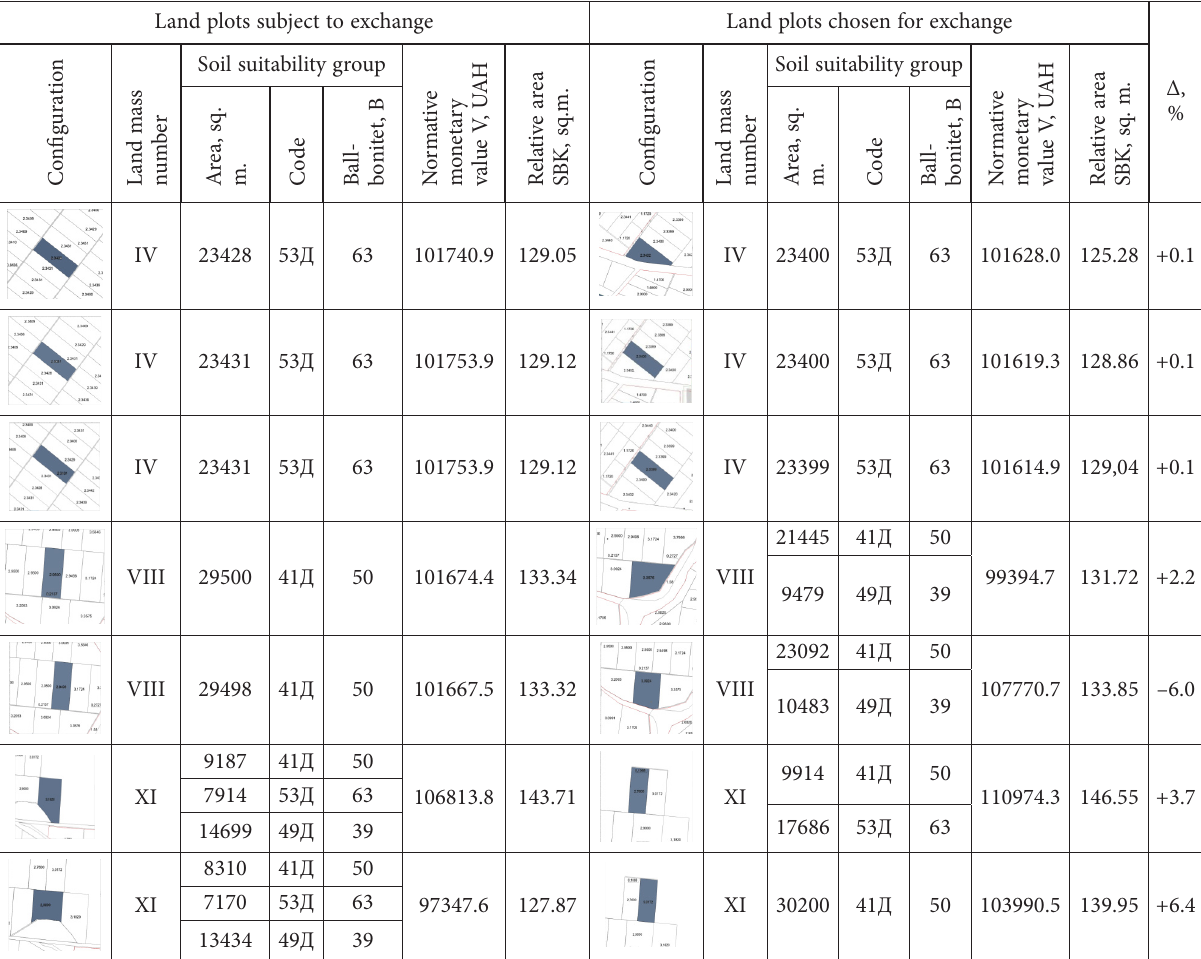
Table 1. Land plots exchange in the land consolidation project (option І) Land plots subject to exchange Land plots chosen for exchange